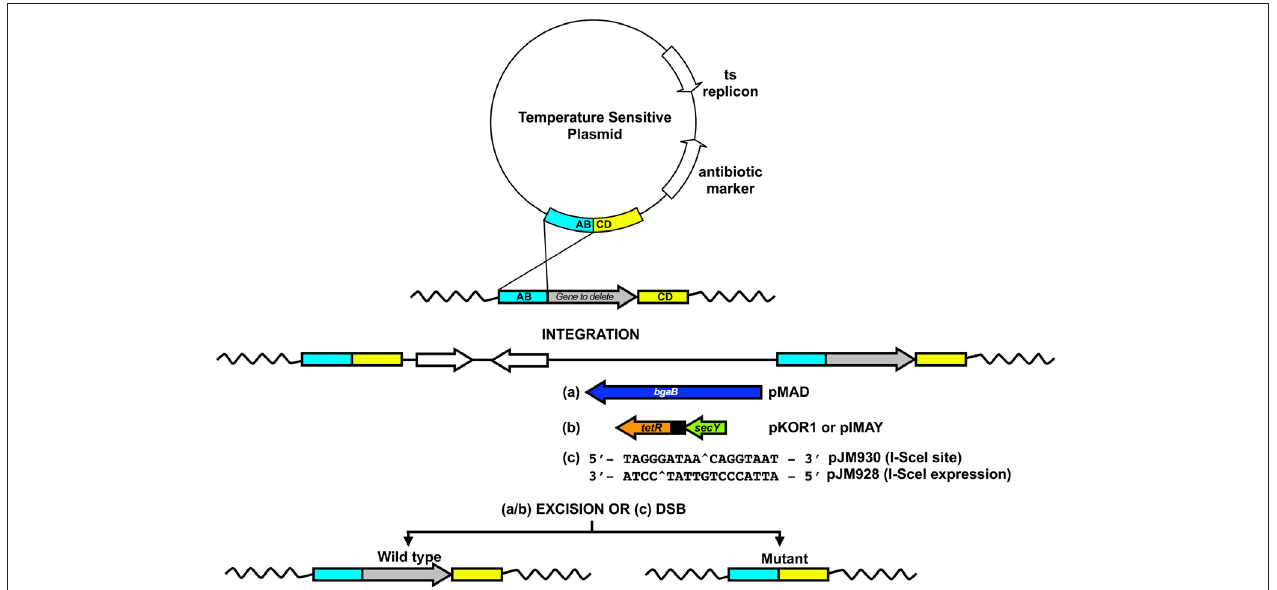
selection stimulates rolling circle replication which leads to vector excision . As described in the text, the different allelic exchange plasmids developed for staphylococci contain additional features which aid in discrimination of colonies lacking the plasmid either post excision, e.g., (a) pMAD: constitutive bgaB for the hydrolysis of the colourmetric substrate—detected as white colonies on X-gal containing agar, (b) pKOR1/pIMAY: ATc inducible secY antisense to repress growth of plasmid-containing strains or (c) I-SceI induced double strained DNA breaks (DSB) which promote homologous